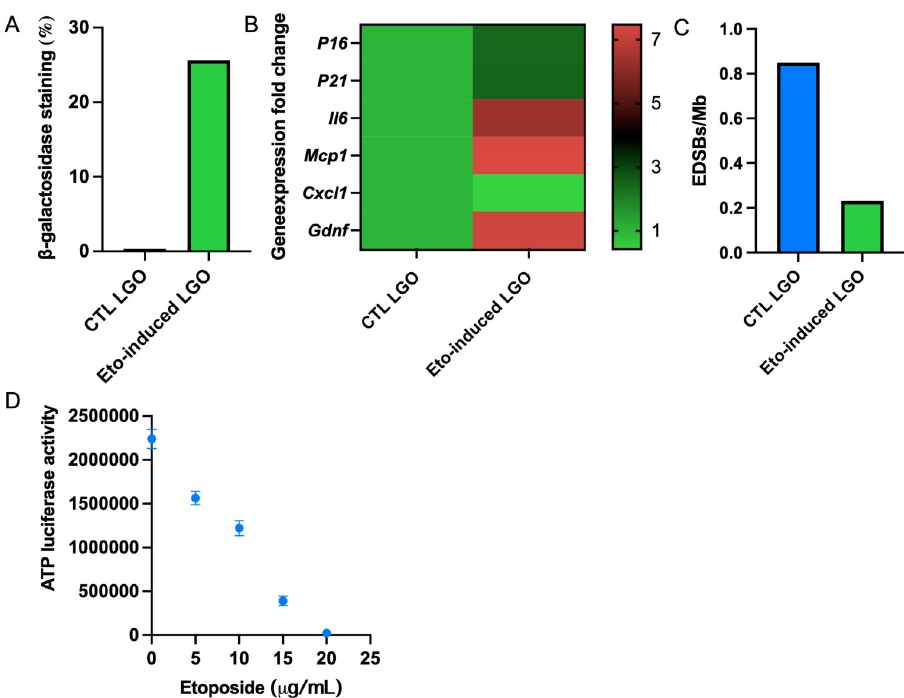
Fig 6. Multi-omics profiling of cellular senescence-induced LG organoids. Senescence markers are evaluated including β -galactosidase activity (A), gene expression arrays (B), and levels of RIND-EDSBs (C) after inducing the organoid with etoposide. For inducing cellular senescence in the organoid, the concentration of etoposide required to create a 50% reduction in metabolism was 10 μ M as determined by ATP-luciferase activity with CellTiter-Glo 1 3D kit from Promega, USA (D). Abbreviations: CTL LGO–control LG organoid with normal epithelial function; Eto-induced LGO–etoposide-induced LG organoid with impaired epithelial function.